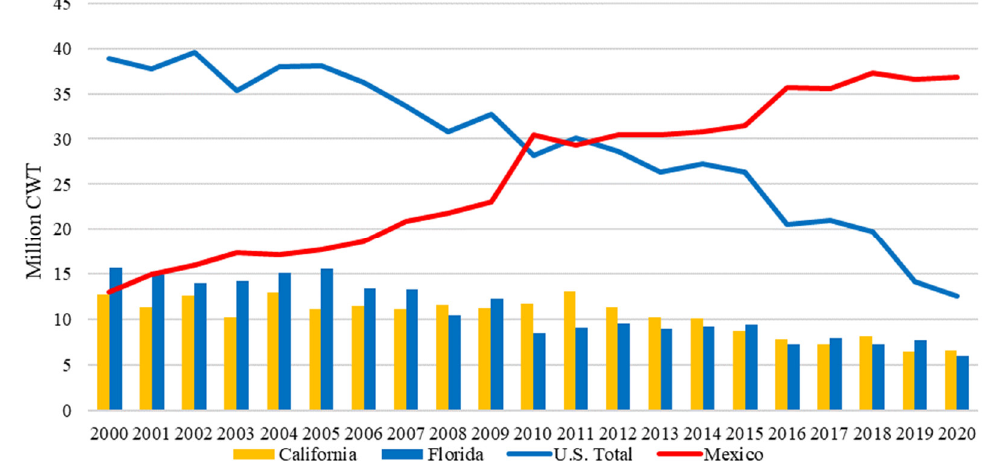
Figure 11. U.S. production and Mexican imports: fresh tomatoes. Notes: The fresh tomato production data of Florida in 2018 is undisclosed and calculated based on the percentages of fresh tomatoes from available data; on average, 96% of Florida total production were sold to the fresh market. Sources: USDA FAS [11] ; USDA NASS [37] .